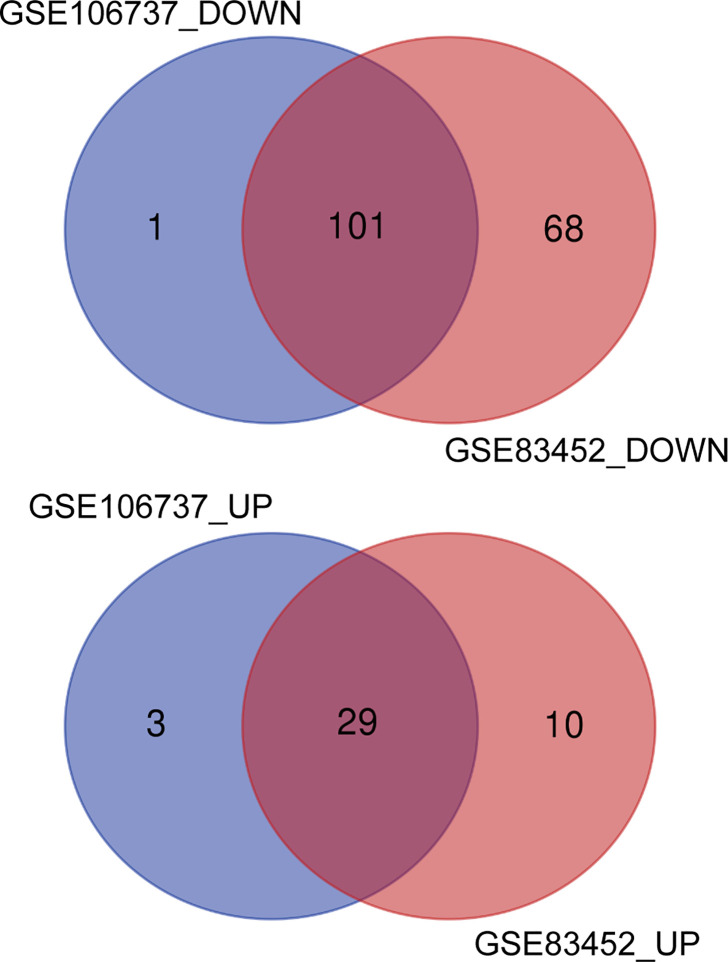
Identification of common DEGs from GSE106737 and GSE83452 using the Venn diagram. The cross section represented the common DEGs. DOWN, down-regulated DEGs; UP, up-regulated DEGs.